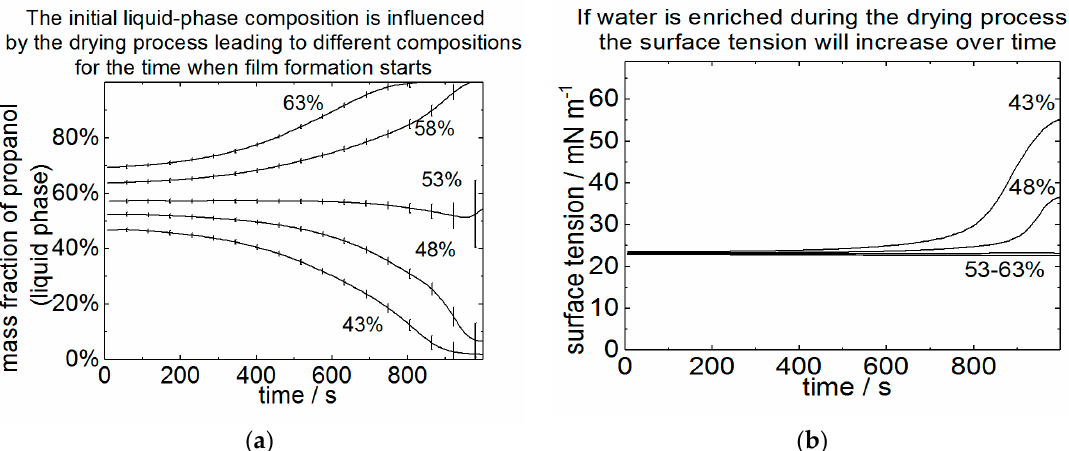
Figure 4. Development of the mass fraction of propanol in the liquid phase of five dispersions used ( a ) as well as the average surface tension development of the dispersions ( b ) as a function of drying time.